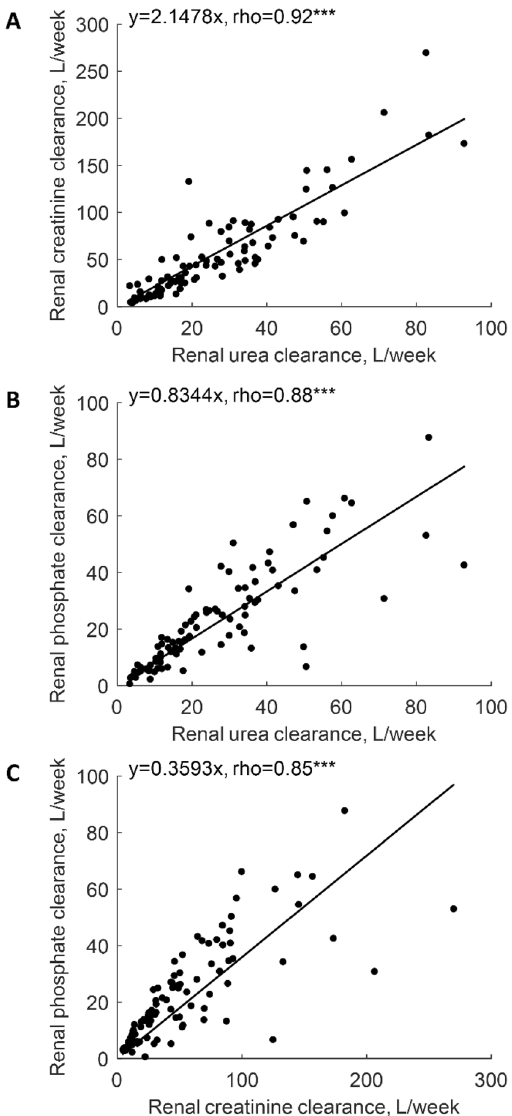
Figure 3. Weekly residual renal clearance of creatinine (panel A ) and phosphate (panel B ) vs. that of urea and renal phosphate clearance vs. renal creatinine clearance (panel C ). *** denote p value <